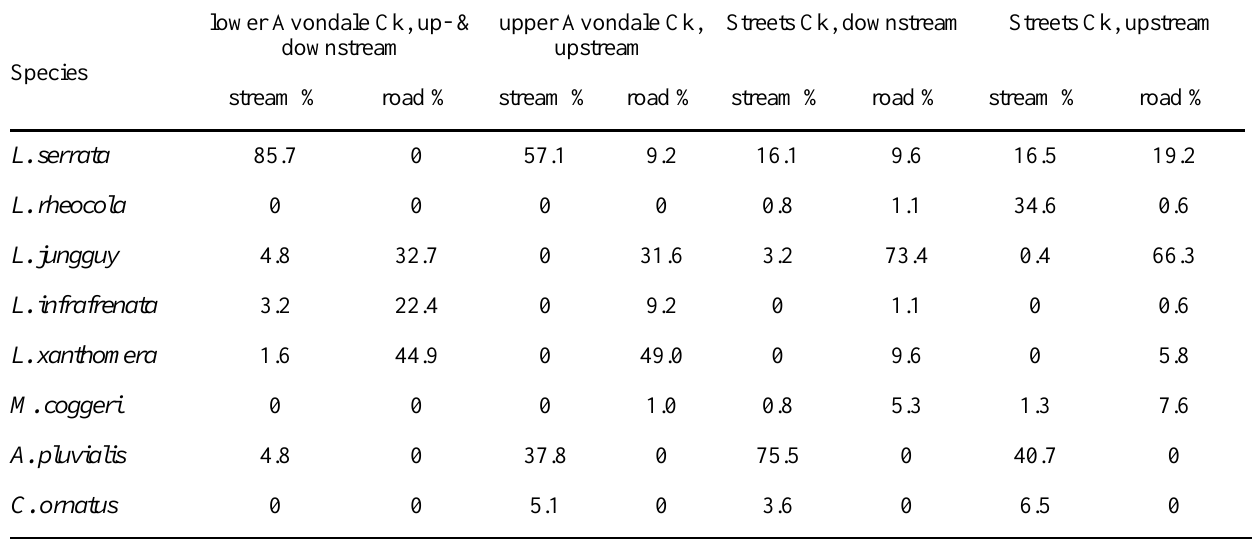
Table 2 . A comparison of frog abundance on stream transects and adjacent road kill transects. Each cell shows the percentage that each frog species represents of the total number of individuals of all frog species recorded on that transect. The stream transect data was collected between January and February 2007, while the road kill data was collected between May 2005 and April 2006. The data for the two lower Avondale Creek stream transects are combined to match the single road kill transect for that area. lower Avondale Ck, up- & upper Avondale Ck, Streets Ck, downstream Streets Ck, upstream downstream upstream %Species stream % road % stream % road % stream % road % stream % road L. serrata